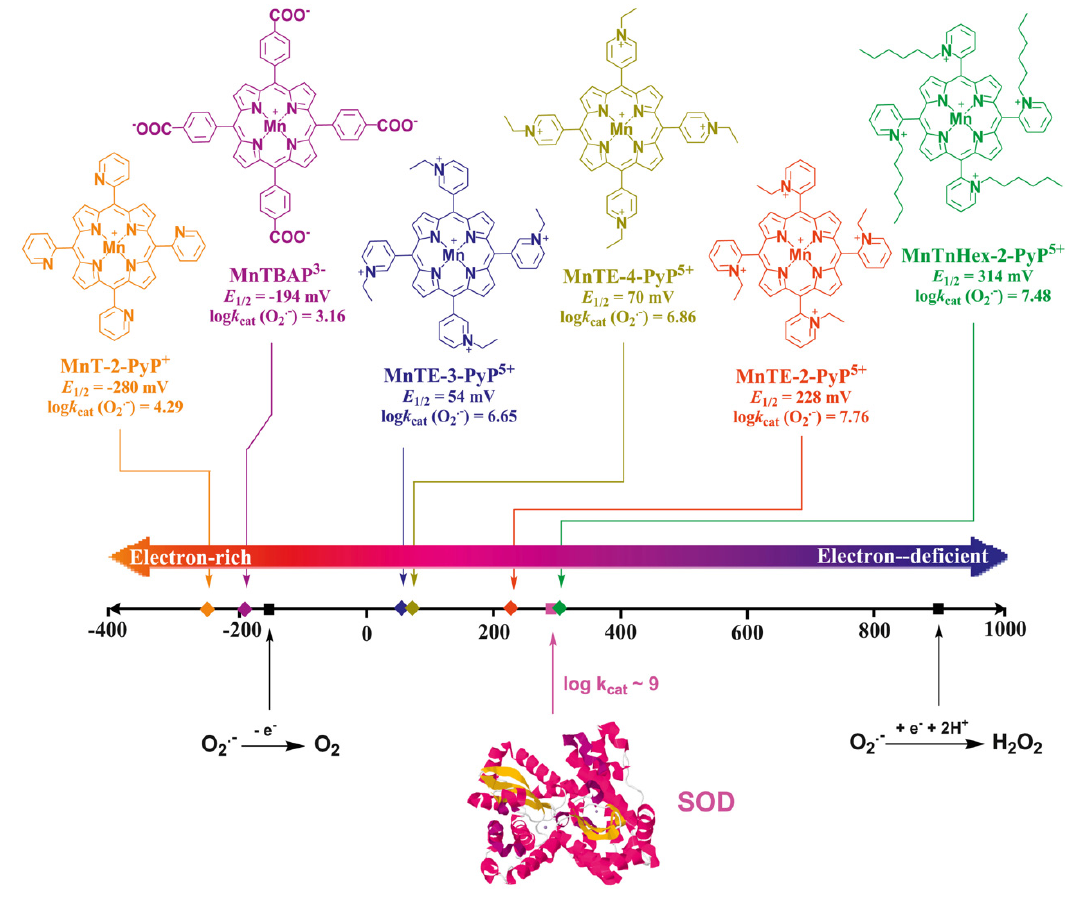
Figure 15. Mn porphyrins that mimic the SOD [98].